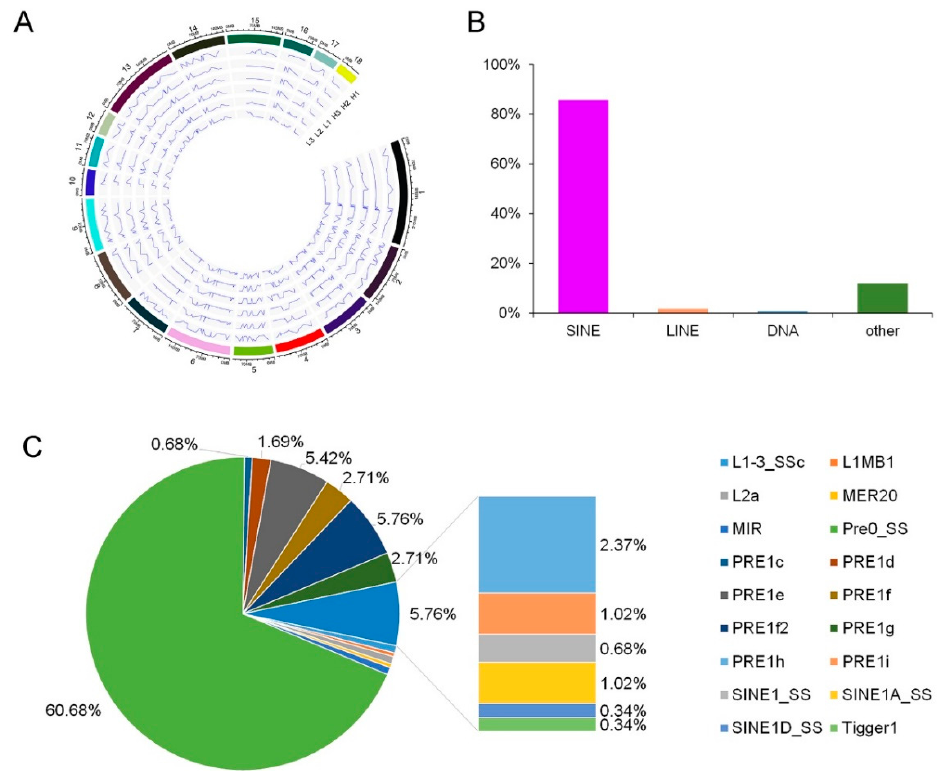
Figure 3. Distribution of RNA editing sites across the genome. ( A ) Distribution of RNA editing sites across chromosomes. The peaks showed the appearance of editing, and the valleys showed the disappearance of editing sites. ( B ) Distribution of RNA editing sites across repetitive classes. SINEs, short interspersed nuclear elements; LINEs, long interspersed nuclear elements. ( C ) Distribution of RNA editing sites across repetitive elements.